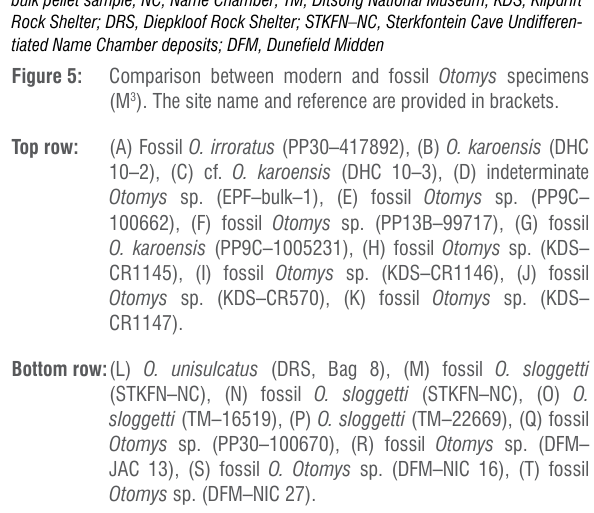
Figure 5: Comparison between modern and fossil Otomys